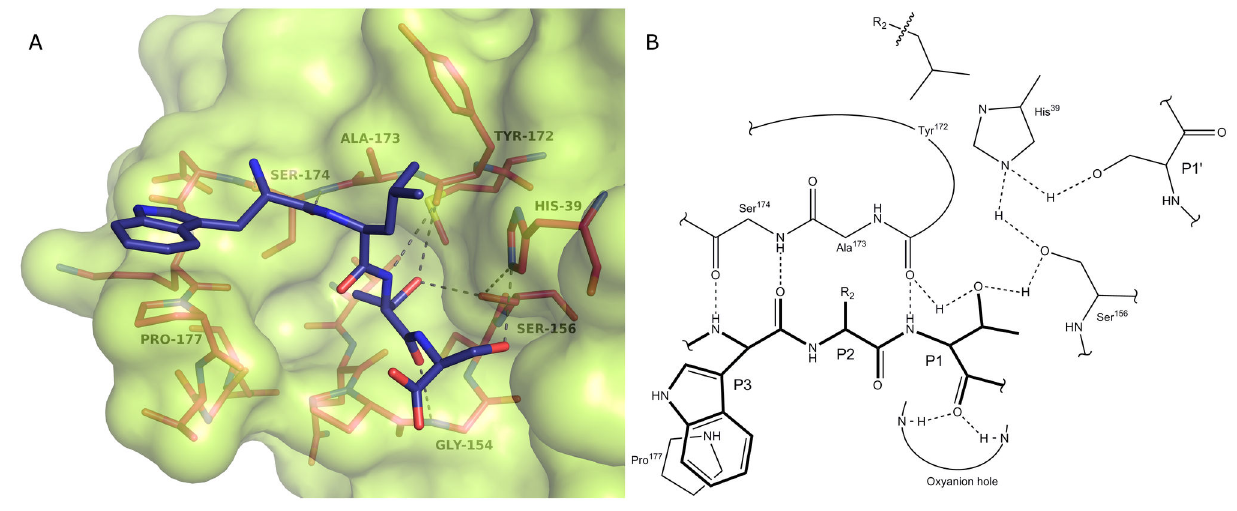
Figure 5. Putative binding mode of the SplD consensus substrate. (A) Residues P4 through P1’ of the consensus substrate (blue) docked to SplD (surface model). (B) Schematic representation of interactions between the consensus substrate (thick lines) and SplD (thin lines). Hydrogen bonds are shown as dotted